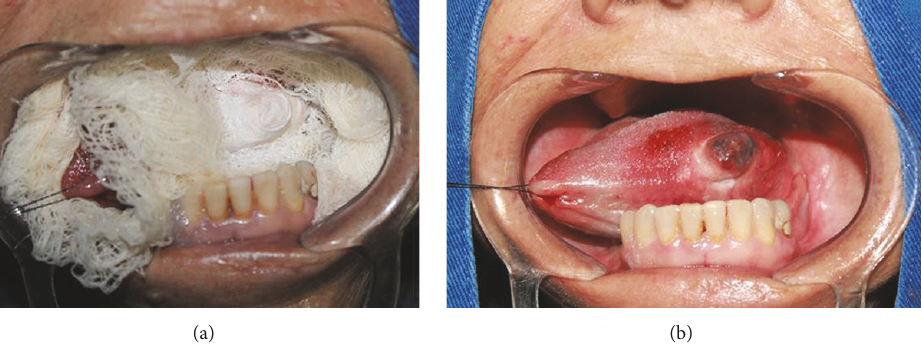
Figure 6: (a) Appearance of the frozen lesion and (b) formation of perilesional edema and erythema in the immediate postoperative period.